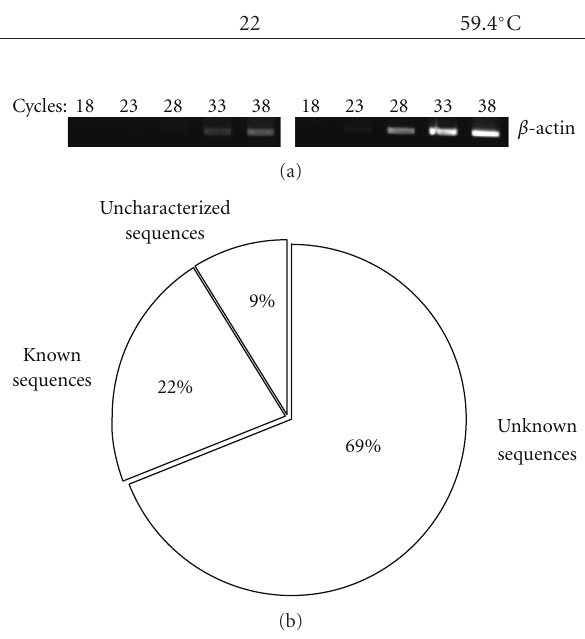
Figure 1: Subtraction e ffi ciency verification and characterization of ESTs. (a) Subtraction e ffi ciency was estimated by polymerase chain reaction (PCR) amplification of β -actin gene on subtracted and unsubtracted cDNA libraries. The number of PCR cycles is indicated above each lane. (b) EST classification represented in subtracted library based on sequence analysis of 117 nonredundant inserts. Known sequences exhibit significant homology with known genes. Uncharacterized sequences were homologous to unanno- tated EST sequences. Sequences with no significant match were called unknown